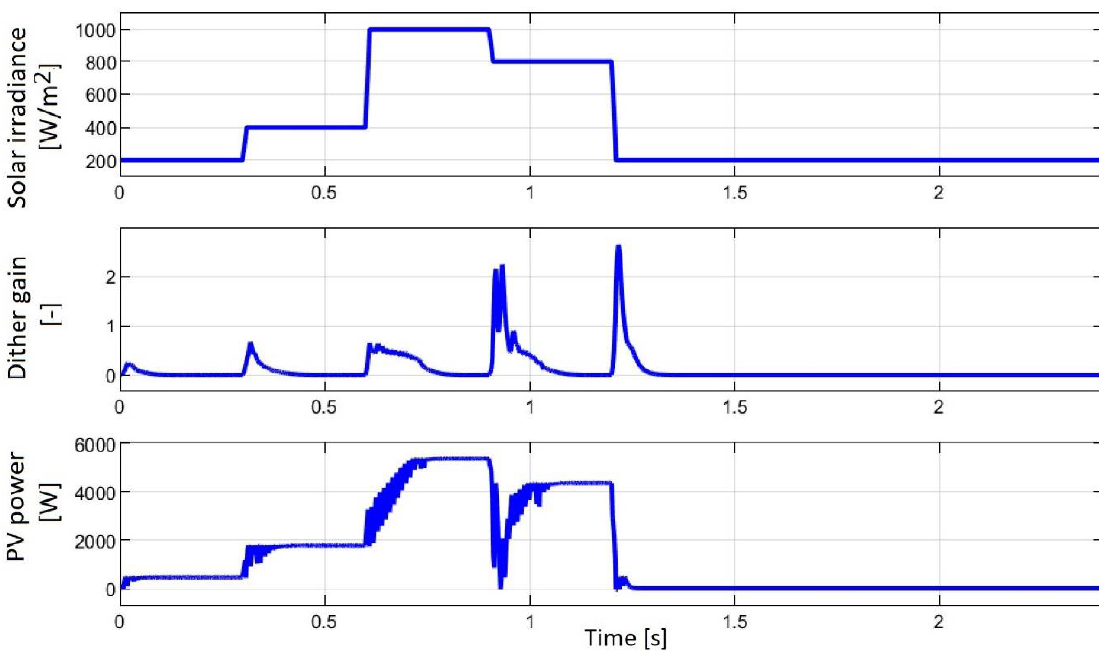
Figure 6. PV/ESS system under variable solar irradiance profile with slow slopes and random pulses of maximum 200 W/m 2 added.